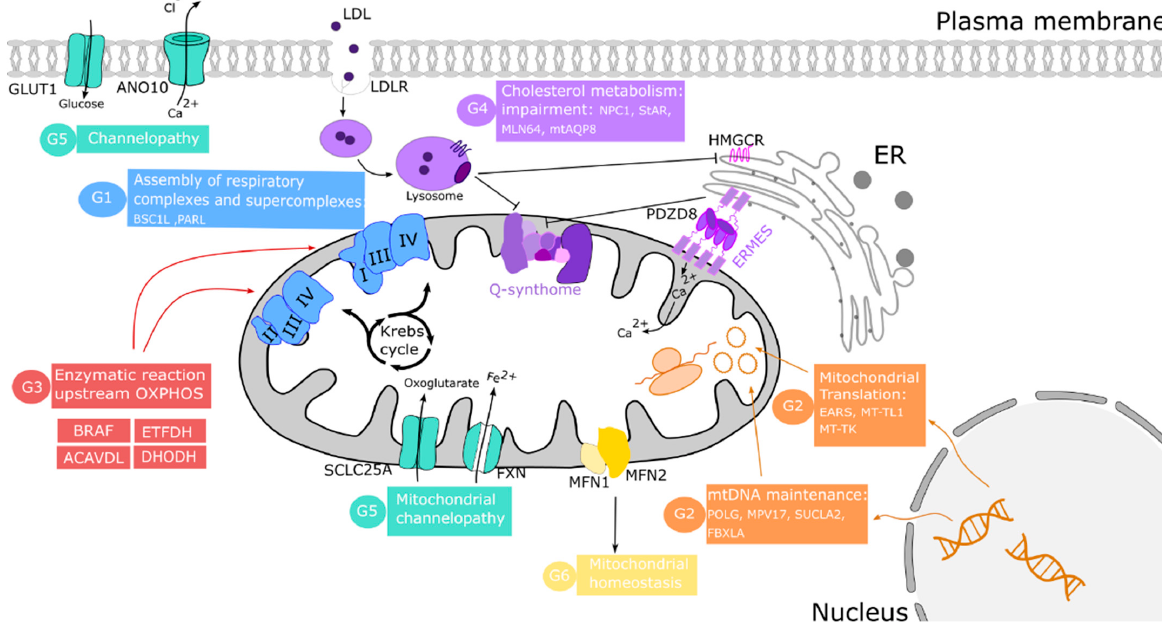
Figure 2. Causes of secondary CoQ deficiency. Mechanisms proposed to trigger the secondary variant are grouped in several categories (G1 to G6) indicated in different colors. The synthesis of CoQ can be reduced by defects in proteins implicated directly or indirectly in the assembly and proper respiratory machinery functioning (G1 (blue) and G3 (red)). In orange (G2) are the essential proteins for the maintenance of intact mtDNA. Point mutations in mitochondrial aminoacyl ‐ tRNA synthetases are also associated with low CoQ levels. The stability of Q ‐ synthome depends on ER ‐ mitochondrial contact sites (ERMES) and the cholesterol synthesis pathway (G4 (purple)). Defects in the proteins implicated in the transport of several metabolites, such as glucose or Fe 2+ , throughout to plasm or mitochondrial membrane cause channelopathies, marked in green (G5). The mechanisms to maintain mitochondrial mass by processes such as fusion ‐ fission proteins, MFN1, and MFN2 (G6) are shown in yellow.